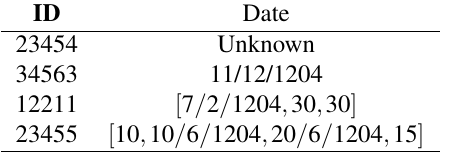
Table 7. Sample of the historical database